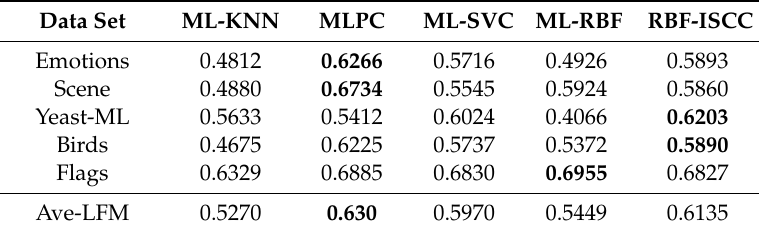
Table 9. Testing labeling F-measure (LFM) obtained for multi-label data sets.